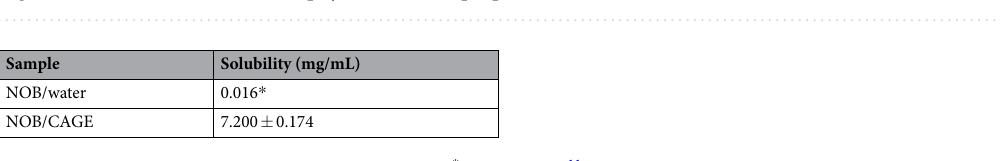
Table 1. Solubility of NOB in water and in CAGE. * Onoue et al . 11